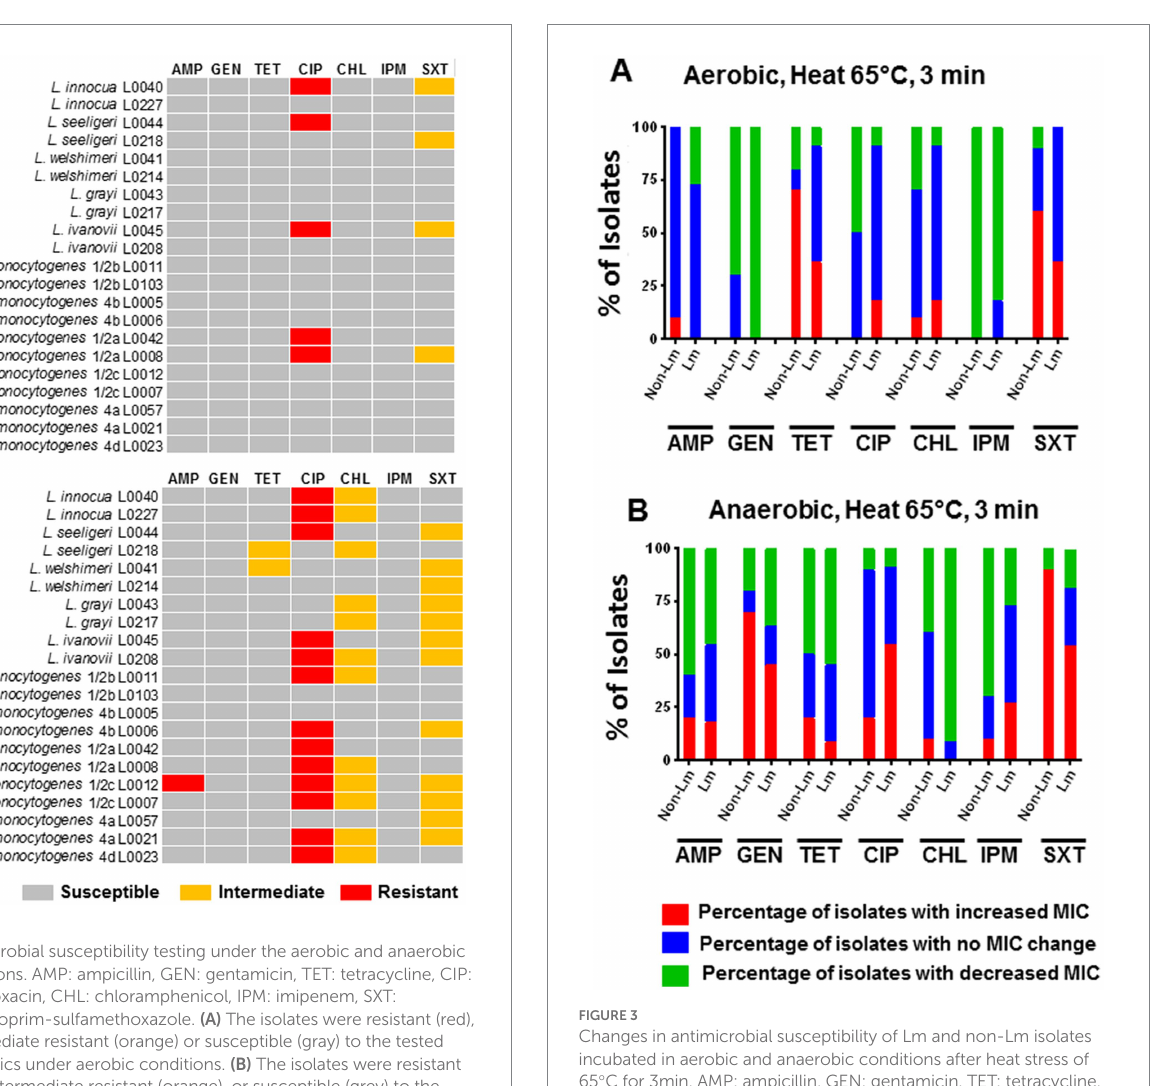
FIGURE 3 Changes in antimicrobial susceptibility of Lm and non-Lm isolates incubated in aerobic and anaerobic conditions after heat stress of 65 ° C for 3 min. AMP: ampicillin, GEN: gentamicin, TET: tetracycline, CIP: ciprofloxacin, CHL: chloramphenicol, IPM: imipenem, SXT: trimethoprim-sulfamethoxazole. (A) Change of MIC (increase/ decrease) after heat stress compared with pre-stress (before stress) under aerobic condition, (B) Change of MIC (increase/decrease) after heat stress compared with pre-stress (before stress) under anaerobic